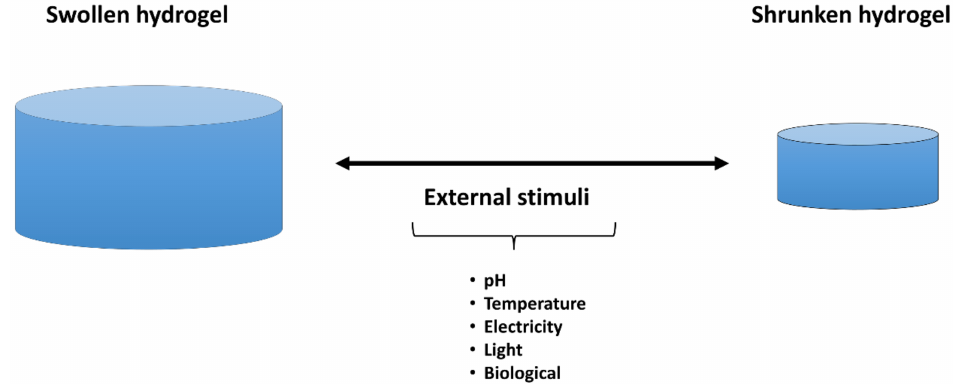
Figure 5. Schematic illustration smart hydrogels subjected to an external